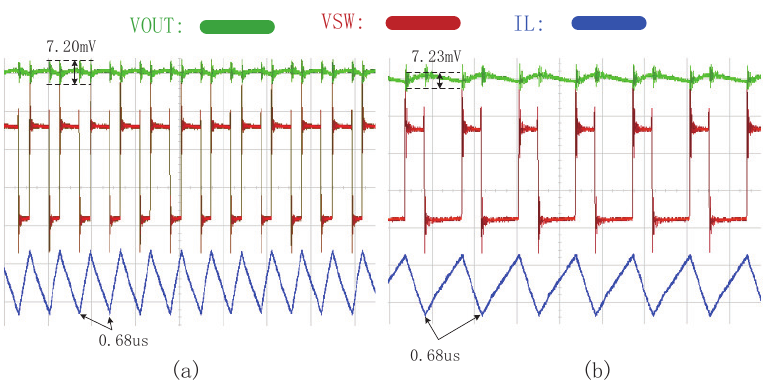
Figure 13. Test results of V OUT , V SW , I SW in PCMC-PWM operating mode of the proposed DCDC Boost converter. ( a ) When the I load is 200 mA. ( b ) When the I load is 250 mA. Figure 15 shows the efficiency of the boost converter for different load currents at an input voltage of 3.6 V. A peak efficiency of 94.7% can be achieved at a load current of 198 mA, and the efficiency is greater than 90% for I load ∈ [30 mA, 300